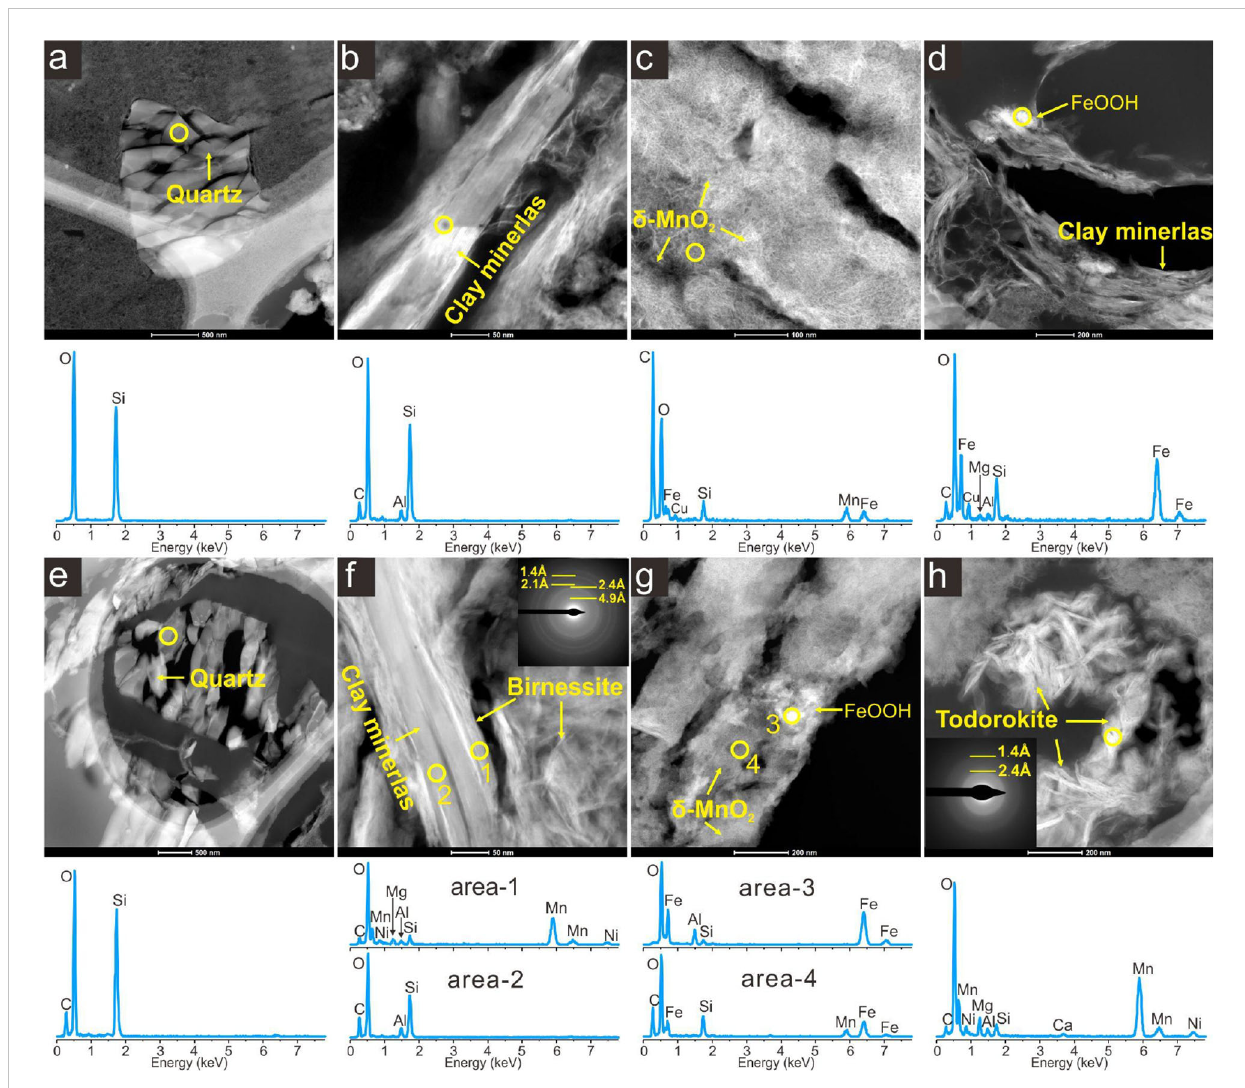
FIGURE 7 TEM photos and micro- in-situ EDS patterns of samples ST1 (A – C) , ZSQD253A (D, E) , and ZJ86 (F – H) in the TEM dark fi